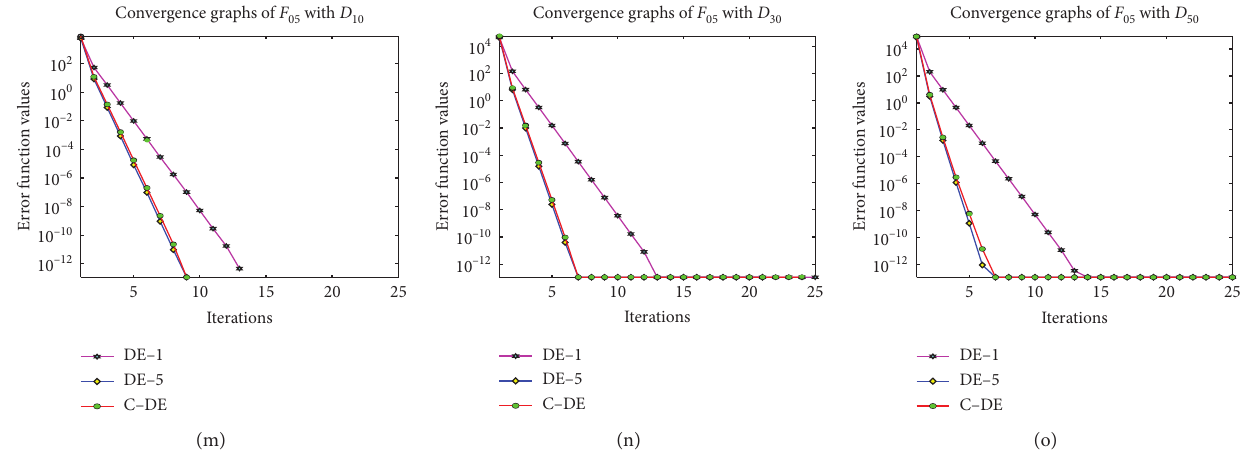
Figure 2: Evolution in the best function values of F